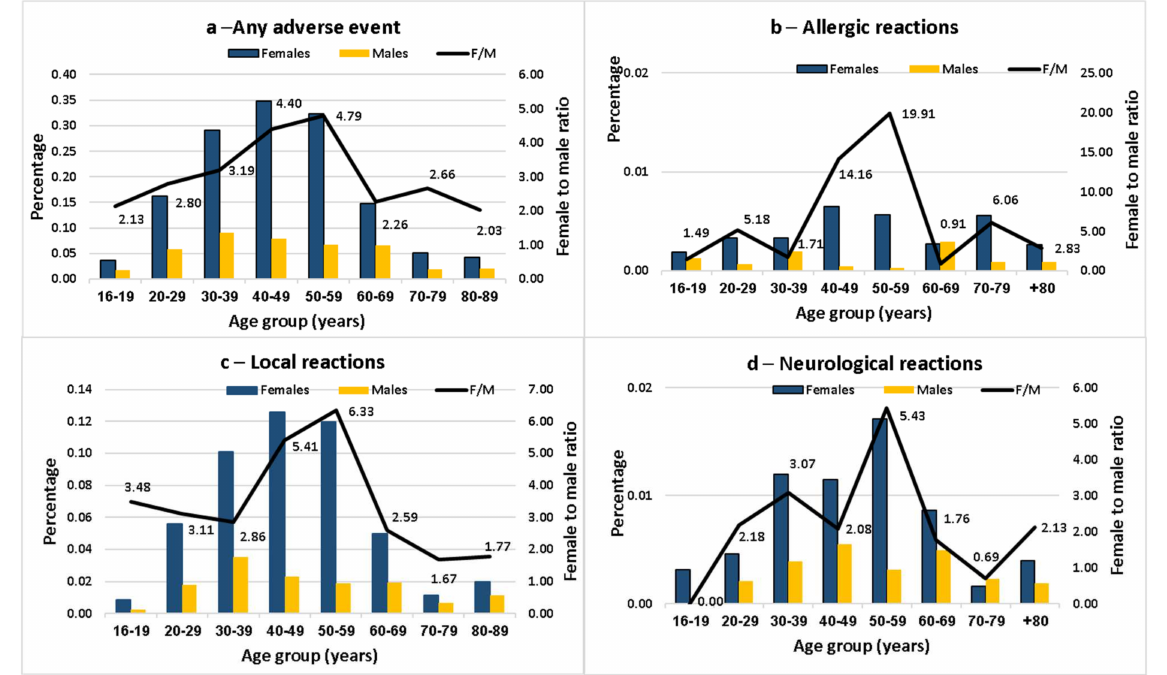
Figure 2. Female-to-male ratio of the percentage reporting adverse events after the second dose of the Pfizer-BioNTech COVID-19 vaccine in the Israel Ministry of Health database, by age